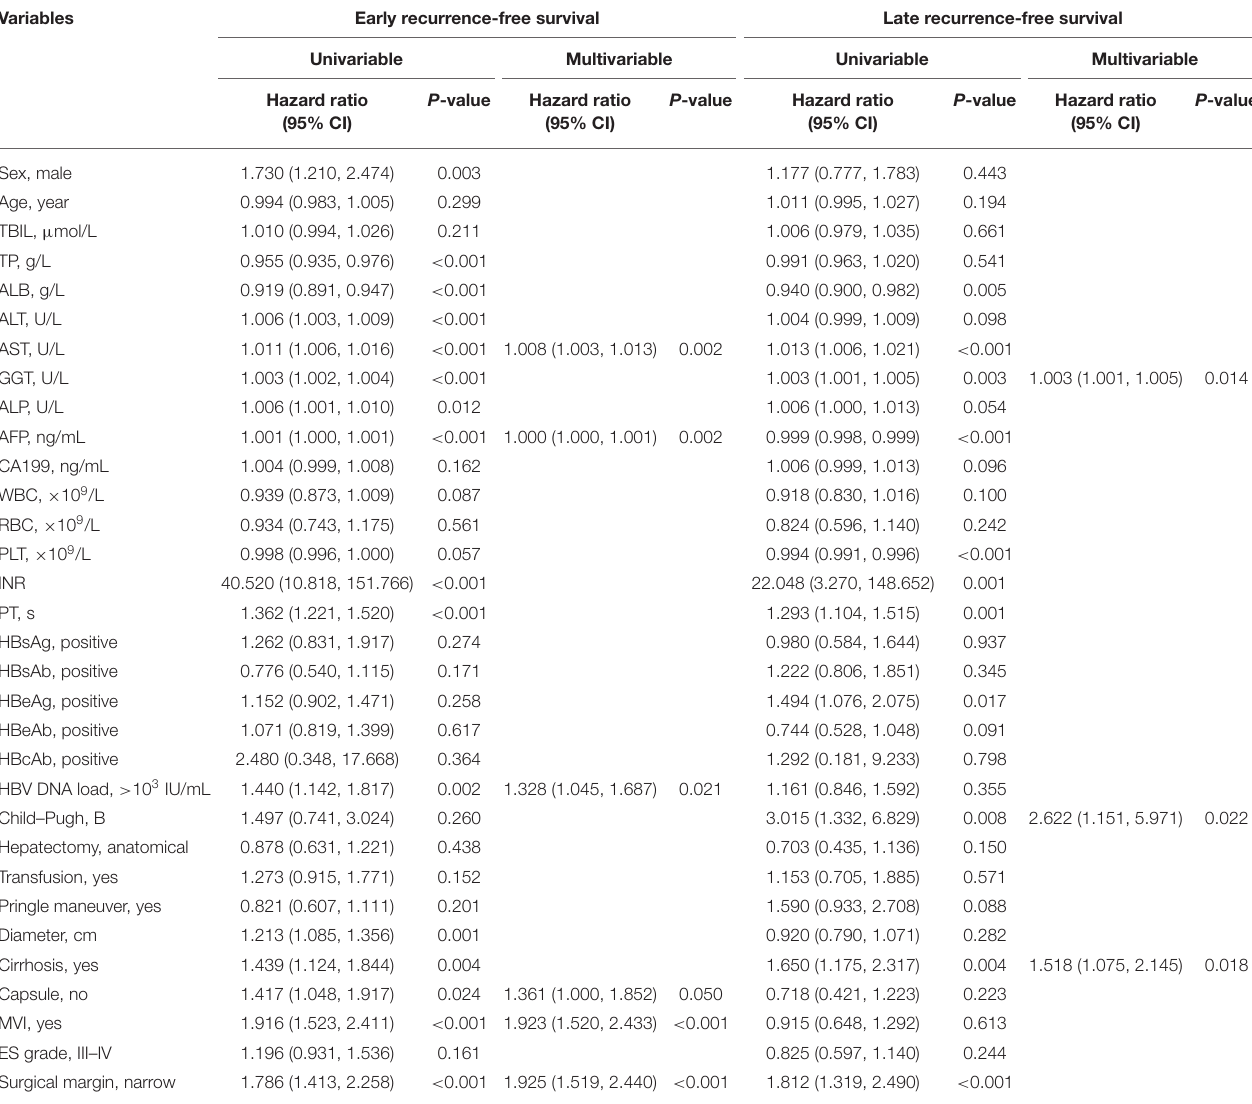
TABLE 3 | Prognosis factors of early and late recurrence in the whole